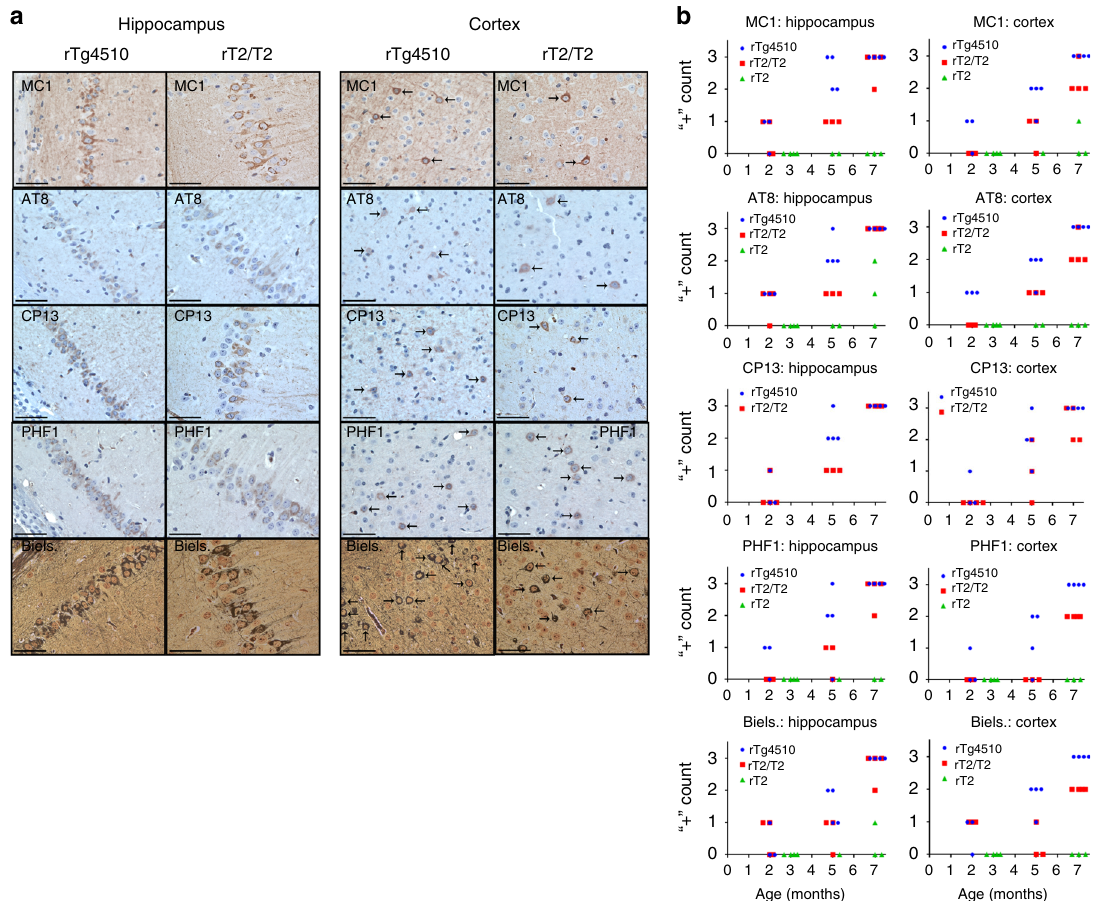
Fig. 6 Comparison of tau histopathology in rT2, rT2/T2, and rTg4510. a Representative 40× images taken from somatomotor cortex and hippocampal CA1 of 7-month-old male rTg4510 and rT2/T2 mice. Stains used to visualize pathological tau aggregates included MC1, AT8, CP13, PHF1, and Bielschowsky (Biels.) silver stains, as indicated. Arrows indicate moderate to prominent positive labeling of tau deposits in cortex, while prominent labeling in hippocampus required no arrows because most or all of the cells exhibited positive labeling. Scale bars represent 50 µ m. b Summary of semiquantitative analysis of tau histopathology progression in rTg4510 ( n = 32M, 4 5M, 47 M), rT2/T2 ( n = 42, 35, 47 M), and rT2 ( n = 42, 25, 37 M) mice. Multiple linear regression analyses revealed signi fi cant regressions for every stain in both regions: AT8 cortex ( F (3, 18) = 55.7, R 2 = 0.89, p < 0.0001), AT8 hippocampus ( F (3,18) = 25.8, R 2 = 0.78, p < 0.0001), Biels. cortex ( F (3,18) = 14.2, R 2 = 0.65, p < 0.0001), Biels. hippocampus ( F (3,18) = 17.3, R 2 = 0.70, p < 0.0001), CP13 cortex ( F (3,18) = 26.3, R 2 = 0.78, p < 0.0001), CP13 hippocampus ( F (3,18) = 40.6, R 2 = 0.85, p < 0.0001), MC1 cortex ( F (3,18) = 34.2, R 2 = 0.83, p < 0.0001), MC1 hippocampus ( F (3,18) = 24.0, R 2 = 0.77, p < 0.0001), PHF1 cortex ( F (3,18) = 18.3, R 2 = 0.71, p < 0.0001), PHF1 hippocampus ( F (3,18) = 17.2, R 2 = 0.70, p < 0.0001). Also using multiple linear regression, a signi fi cant difference between rTg4510 and rT2/T2 y -intercepts was found for AT8 in the cortex ( p = 0.017) and between rTg4510 and rT2/T2 progression of pathology (slope) for Biels. in the cortex ( p = 0.024). A signi fi cant